Question: In one sentence, what is this figure communicating?
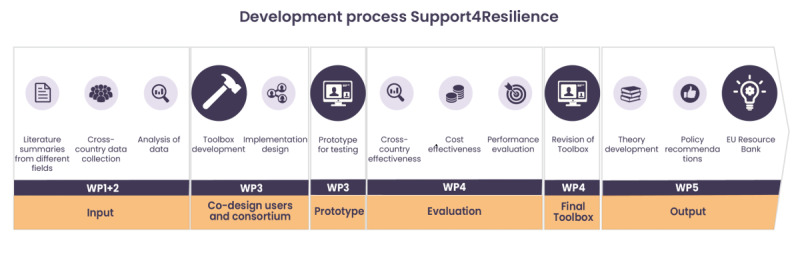
Answer: Final Support4Resilience (S4R) development process. EU: European Union; WP: work package.